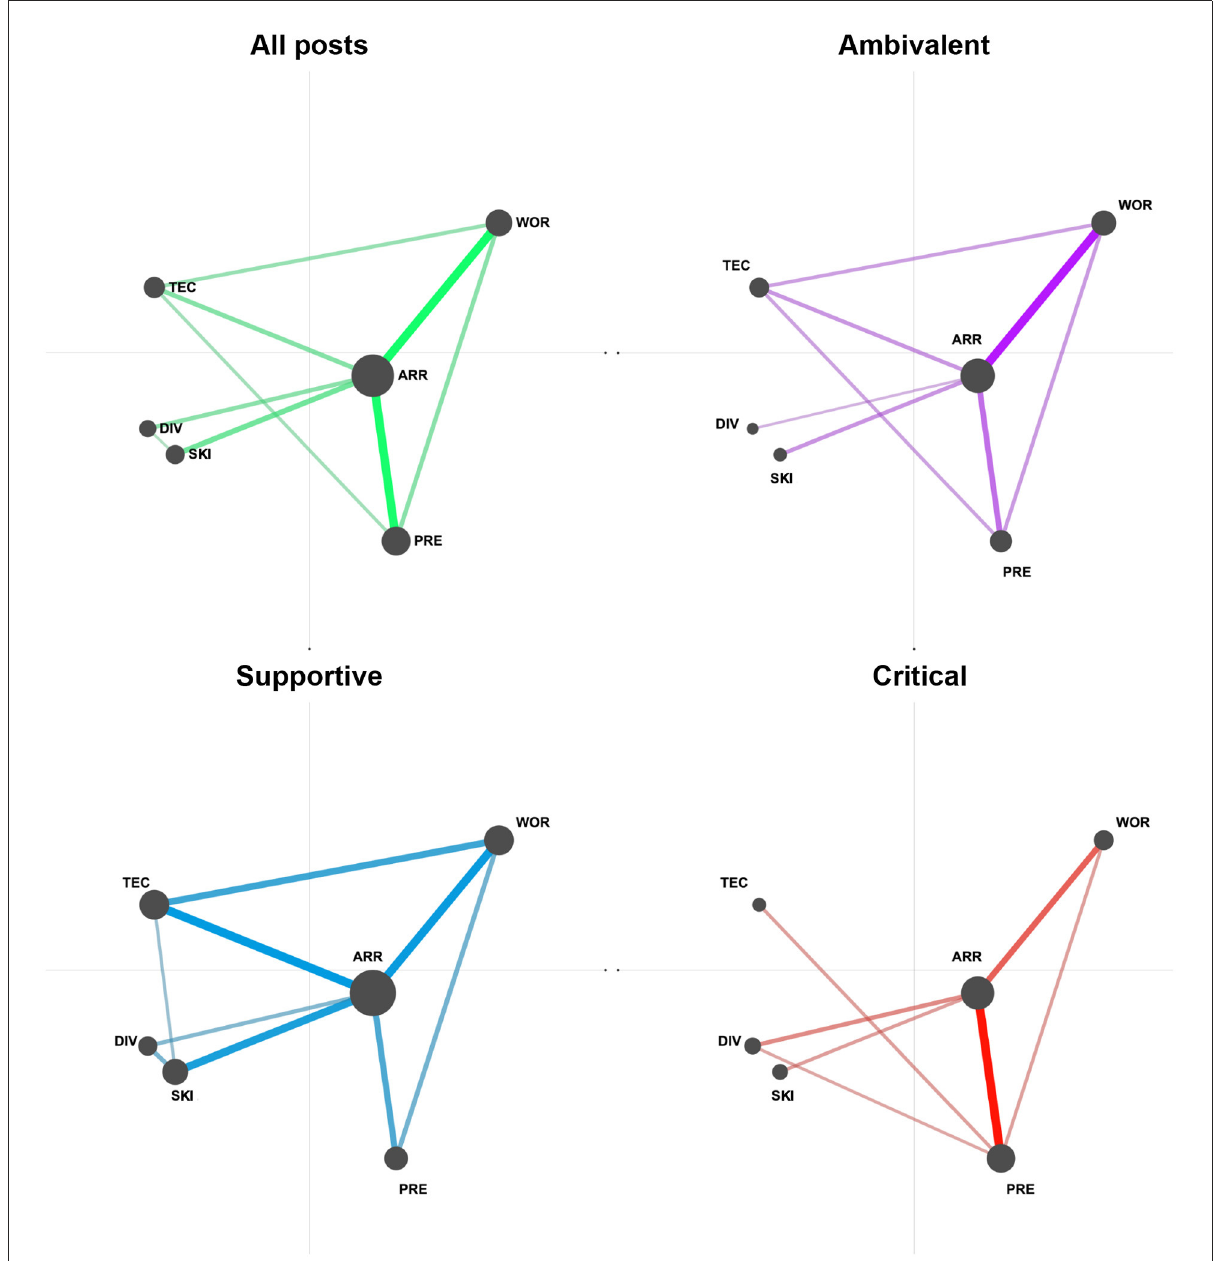
FIGURE1 Mean networks of posts with different perspectives on the presented scenario.